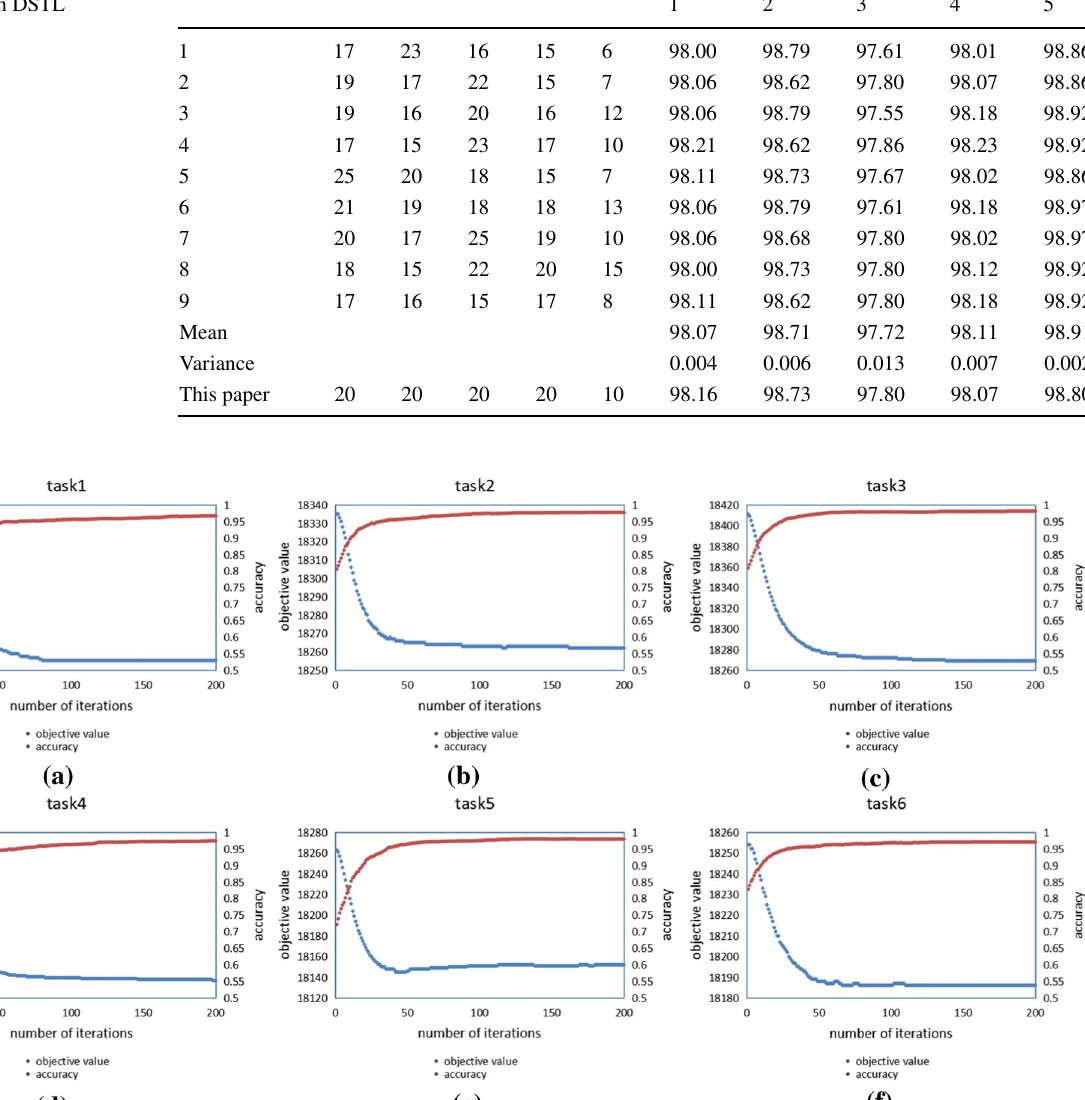
Table 7 The influence of parameters on the performance (%) of Algorithm DSTL